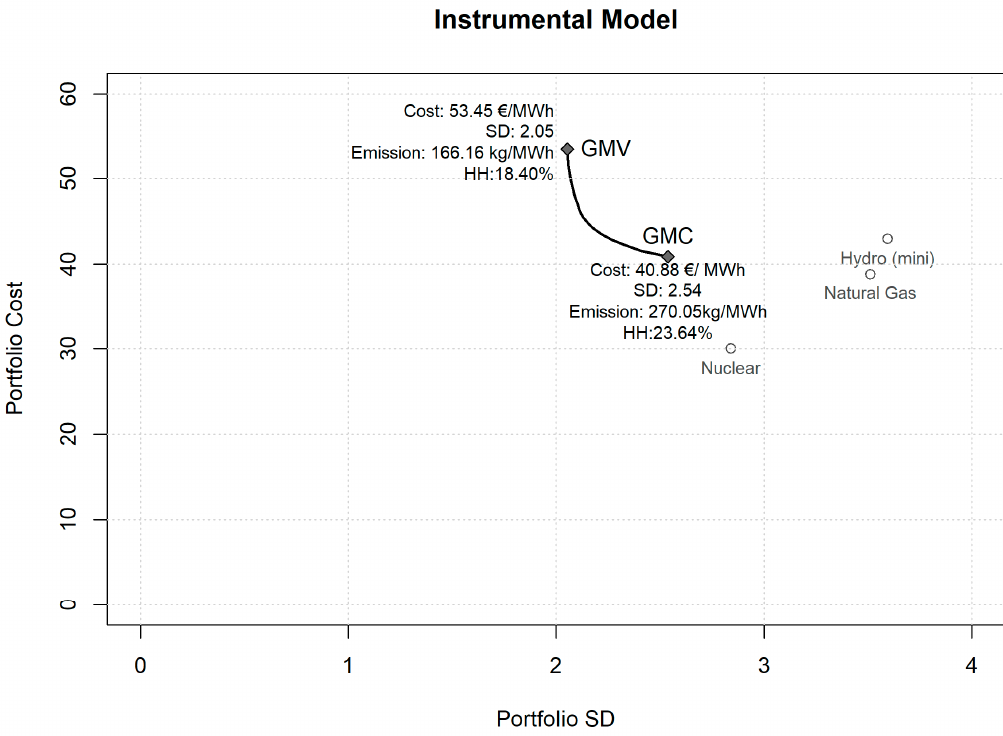
Figure 1. Instrumental model’s efficient frontier.